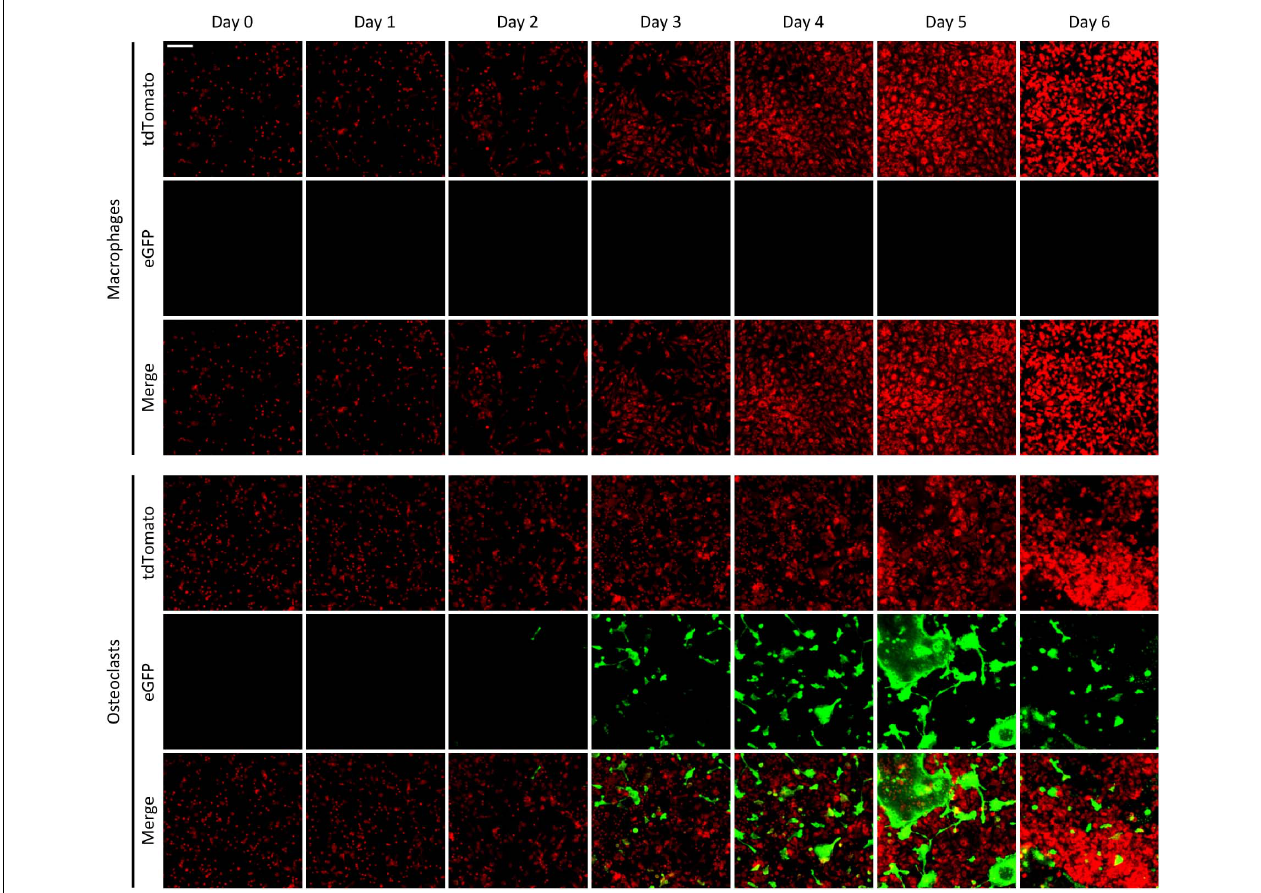
FIGURE 3 | The time-course of fluorescence changes in the FRAMCO1.1 assay. Representative images of Ctsk-Cre/mTmG macrophages and osteoclasts captured on the indicated days (Day 0 is the time RANKL was first added to osteoclast cultures). Red and green channels supposedly correspond to the indicated fluorophores. The scale bar corresponds to 100 µ m and applies to all images. Images are representative of 8–10 independent